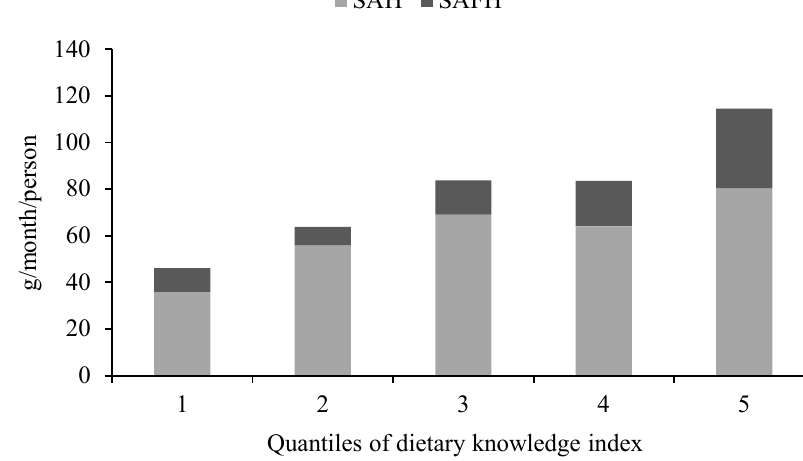
Figure 4. Seaweed consumption by DKI.